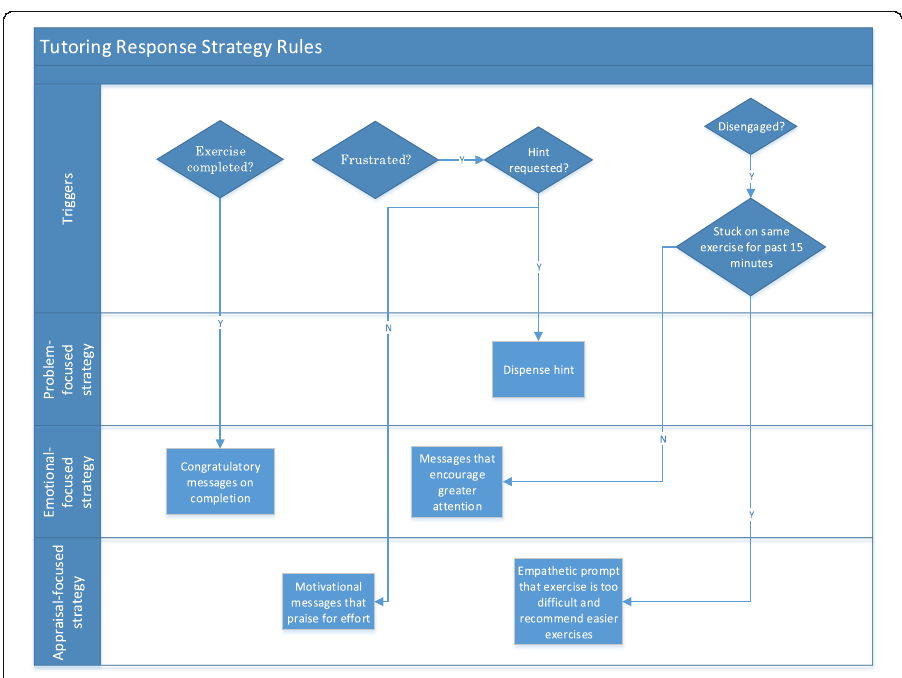
Fig. 2 Tutoring Response Strategy Rules of